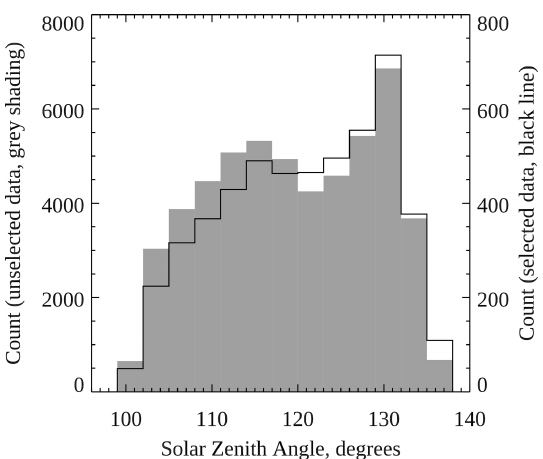
Figure 5. Histogram of the solar zenith angle at the time of the peak emission height measurements. The black line shows selected data (blue height above 130km and at least 10km above the green height) using the right ordinate axis, and the grey shading shows all remaining unselected data using the left ordinate axis.